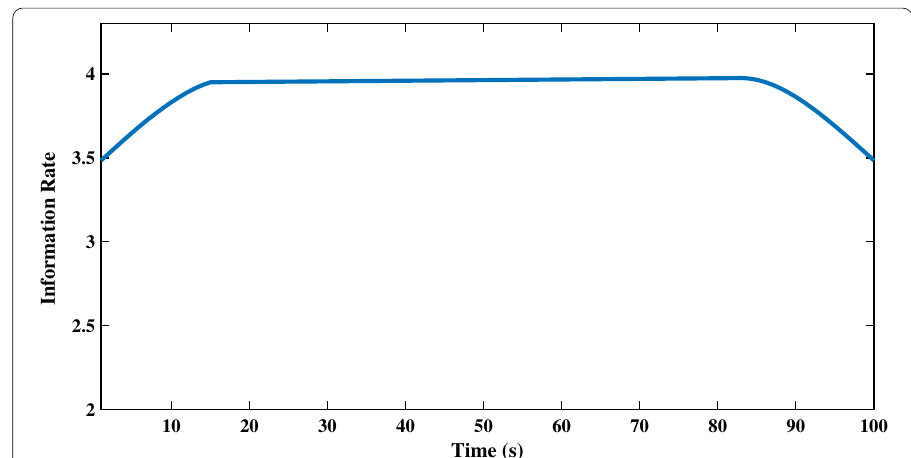
Fig. 9 Optimal information rate for the trajectory optimization with fixed power allocation